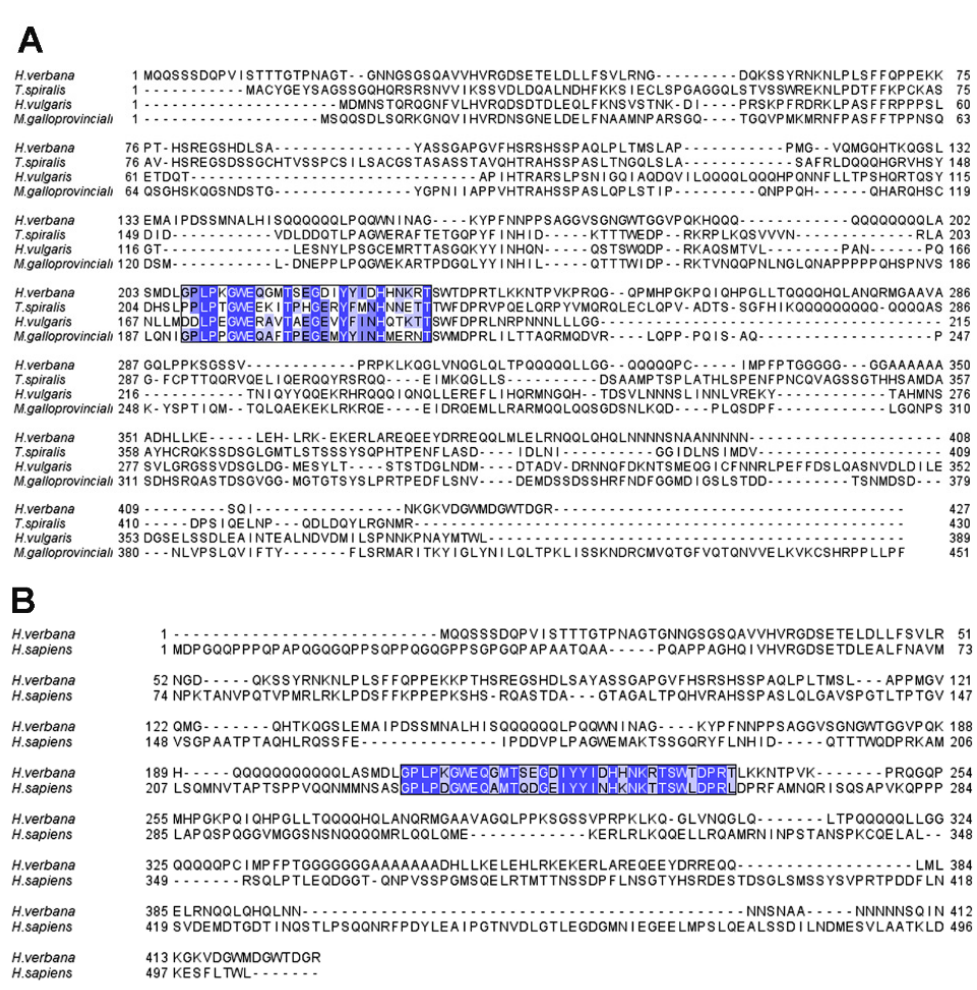
and M. galloprovincialis (Figure 8A), highlighting the high conservation of a WW motif also in the medicinal leech protein. A similar result was also obtained by comparing human and leech YAP1, revealing a fundamental similarity with vertebrates as well (Figure 8B).